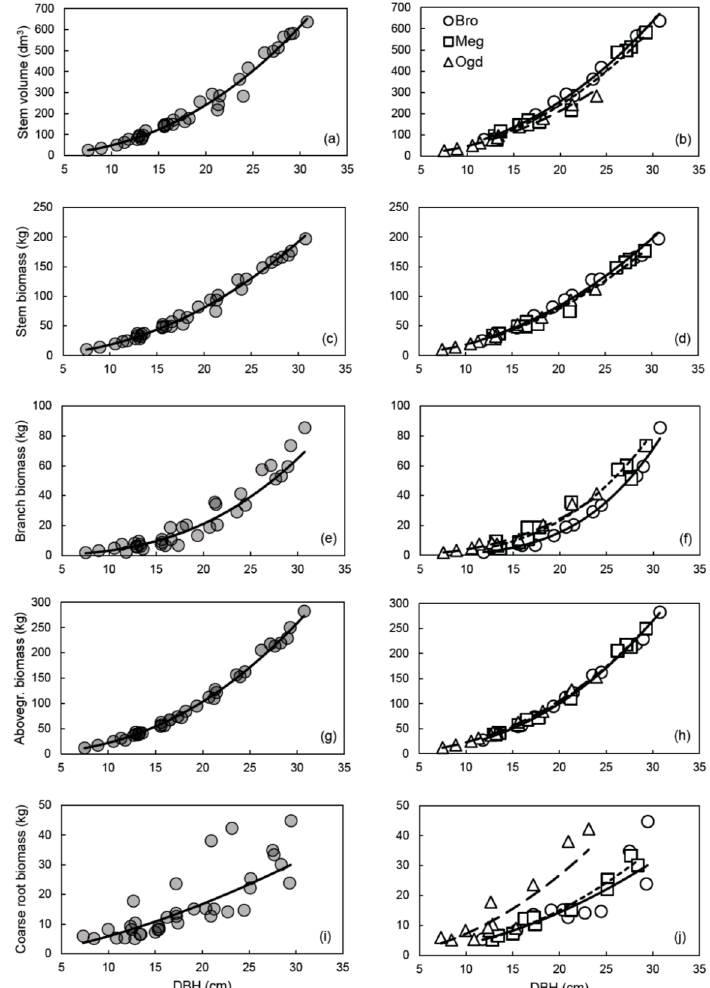
Figure 1. General allometric relationships (left panels) and site-specific allometric relationships (right panels) between DBH and stem volume ( a , b ), stem biomass ( c , d ), branch biomass ( e , f ), aboveground woody biomass ( g , h ), or coarse root biomass ( i , j ). In the right panels: Brompton (Bro), solid line; Mégantic (Meg), small-dashed line; Ogden (Ogd), large-dashed line. All models are in the form of the simple power law equation Y = aX b , using untransformed data. See Table 3 for the parameter estimates and detailed statistics of each relationship on the logarithmic scale.